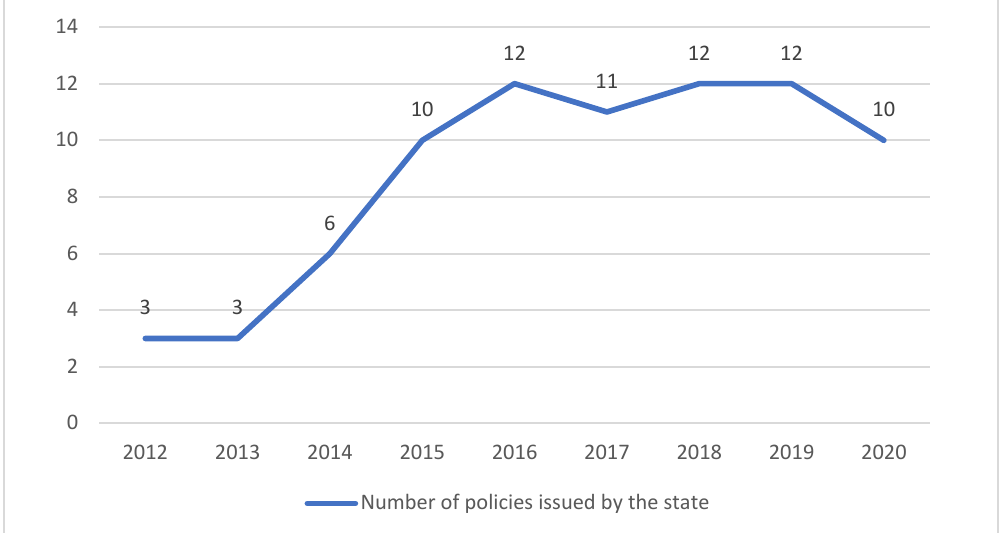
Figure 1. Number of policies related to charging infrastructure construction from 2012 to 2020 (at the national level). Data Source: public policy documents of the government